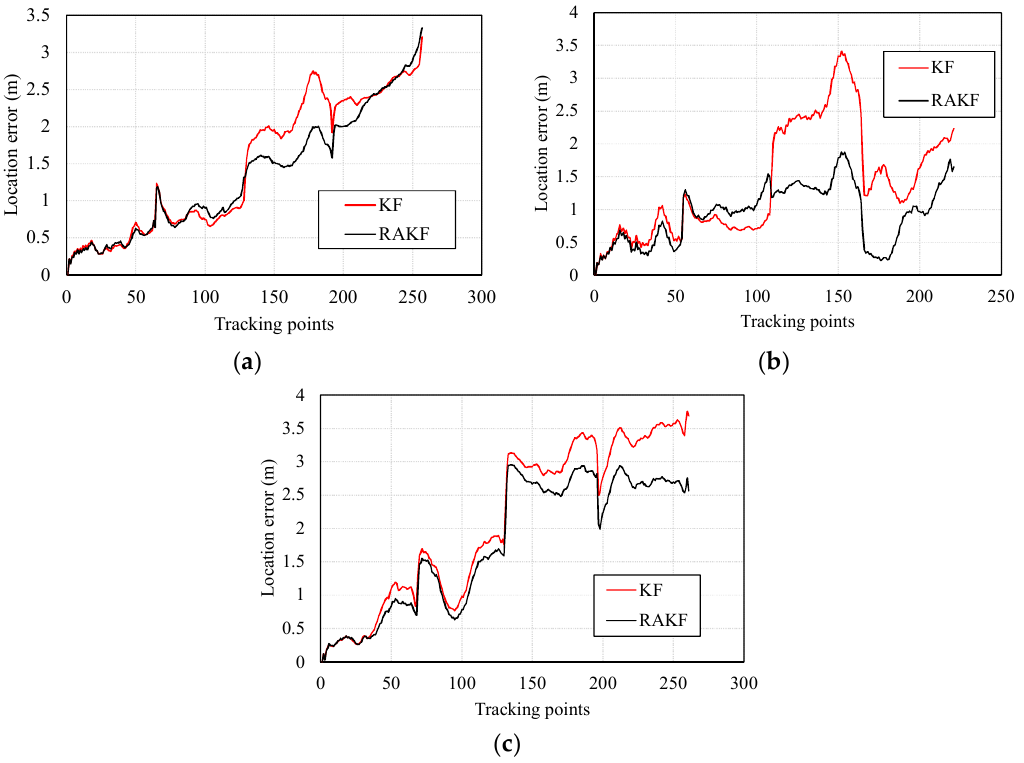
Figure 9. Distributions of location errors in location tracking of KF and RAKF with respect to three participants, ( a ) participant 1, ( b ) participant 2, and ( c ) participant 3. Table 3. Statistical results of location errors.